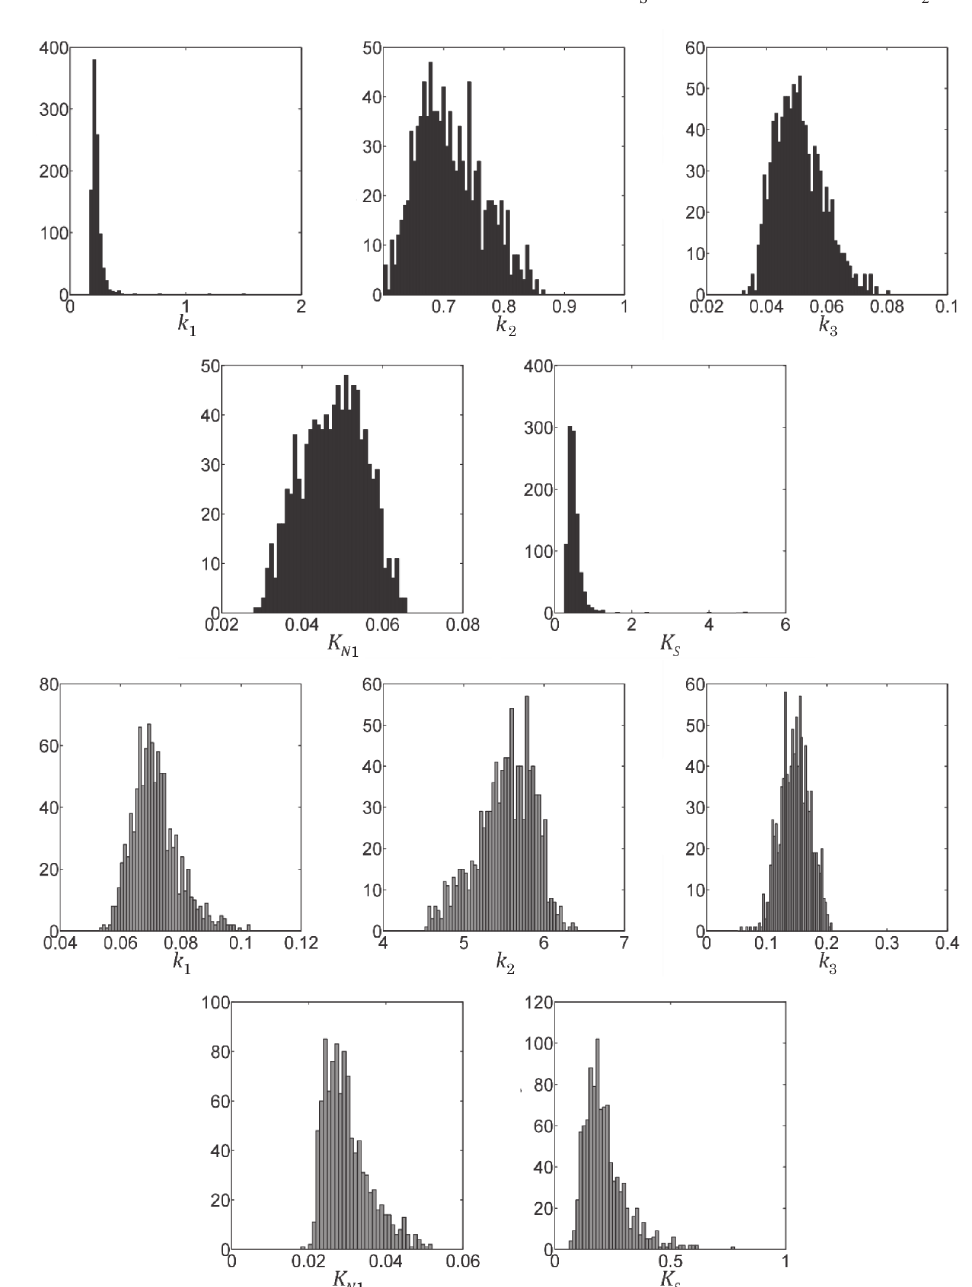
Fig. 5 – Parameter distributions. The histograms show the distribution for parameters of both wild (black) and mutant (gray) strains. Data taken from bootstrap results.